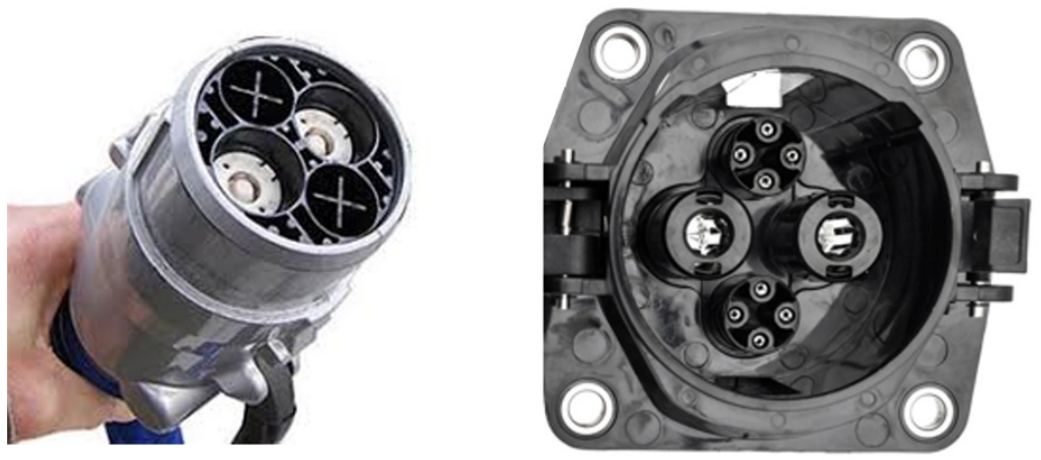
Figure 17. The CHAdeMO coupler: EV Plug ( Left ) and Inlet ( Right ).